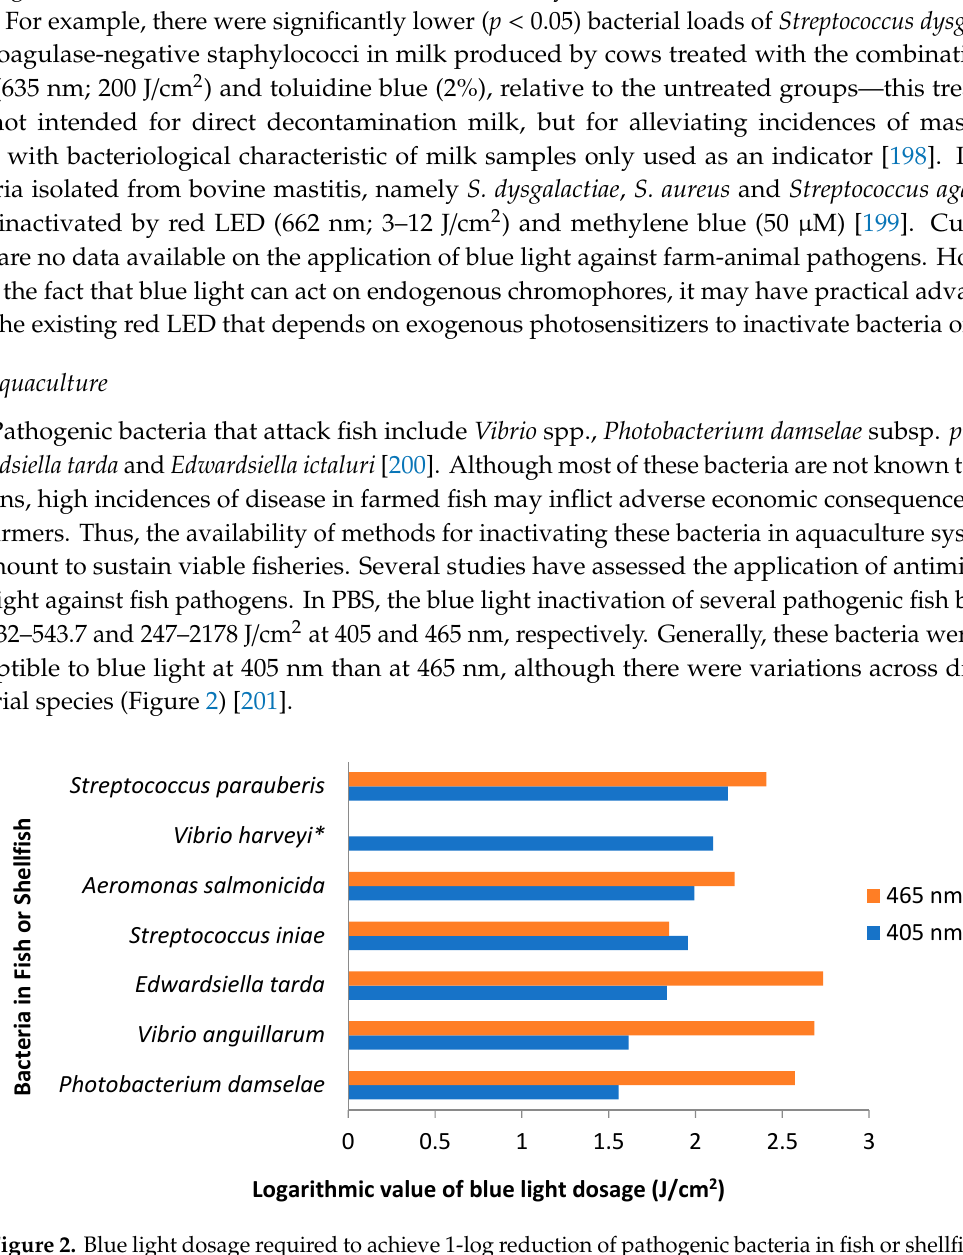
Figure 2. Blue light dosage required to achieve 1-log reduction of pathogenic bacteria in fish or shellfish. Light dosage was converted to logarithmic values (log) and thus an increase of one unit on the x axis represents a tenfold increase in the light dosage. This graph was created using data taken from Roh et al., which was published under the Creative Commons Attribution 4.0. International License (http: // creativecommons.org / licenses / by / 4.0 / ) [201]. * Vibrio harveyi was not inactivated by blue light at 465 nm.